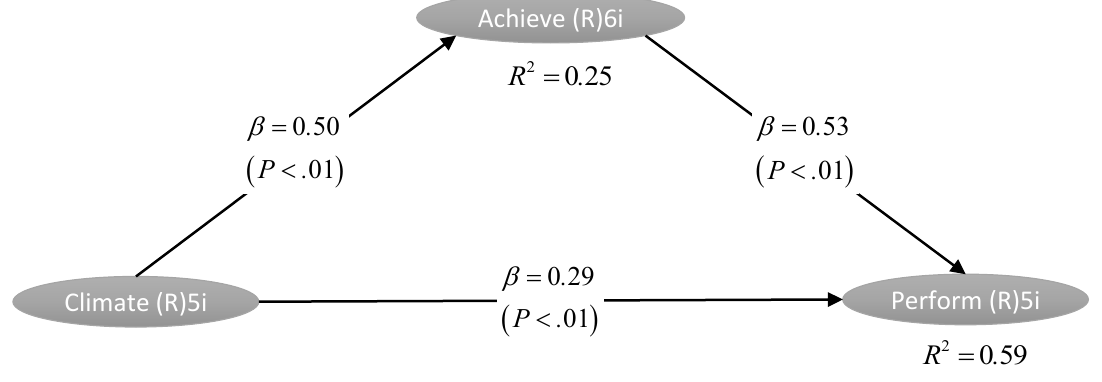
Figure 1. The path analysis of research